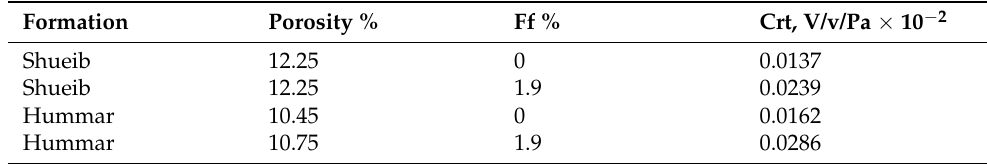
Table 4. Calculated pore volume